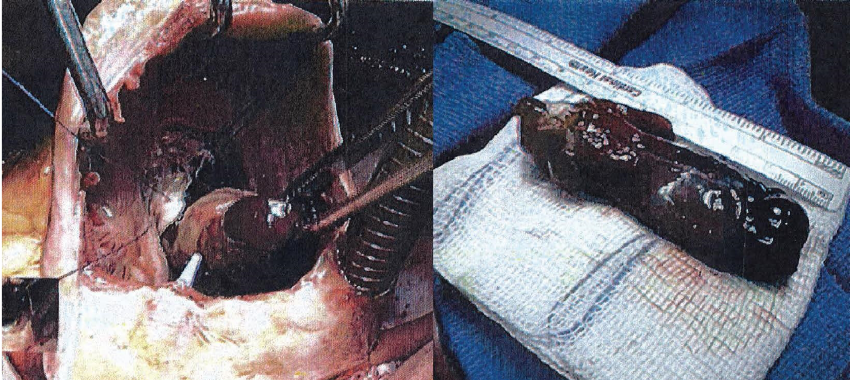
Figure 5: Intraoperative view shows a soft and friable red gelatinous mass being retrieved from the right atrium.